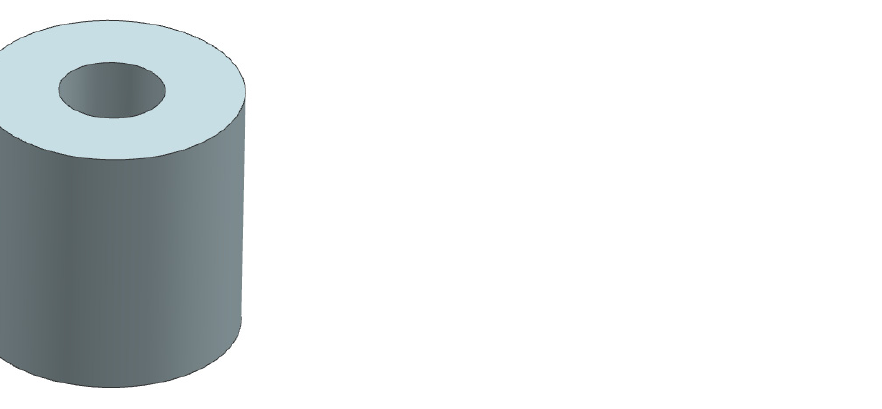
Figure 13. Suggested specimen geometry for the determination of the penetration depth.